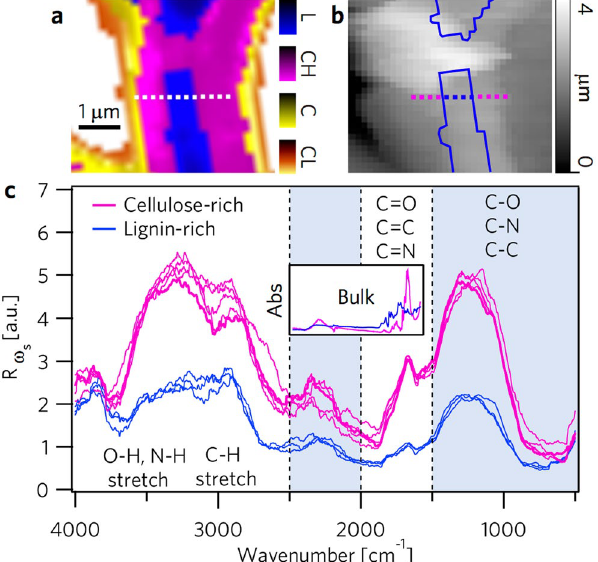
Figure 6. Hyperspectral interogration across cell wall by wideband infrared nanospectroscopy. ( a ) Raman image of EF prepared by cluster analysis. The square markers of 200 nm pitch indicate where nano-spectra were acquired across a cell wall cross section. ( b ) A corresponding topographic image acquired by AFM, where lignin areas are outlined and the square markers are color-coded based on the material composition. ( c ) The wideband nanospectra acquired through PAS-AFM produces a characteristic difference in signal strength between cellulose and lignin (color assignment based on probe location). For comparison, the infrared (bulk) absorption spectra of cellulose Avicel and lignin acquired by FTIR, plotted at the same range of 4000 to 500 cm − 1 , are shown in the